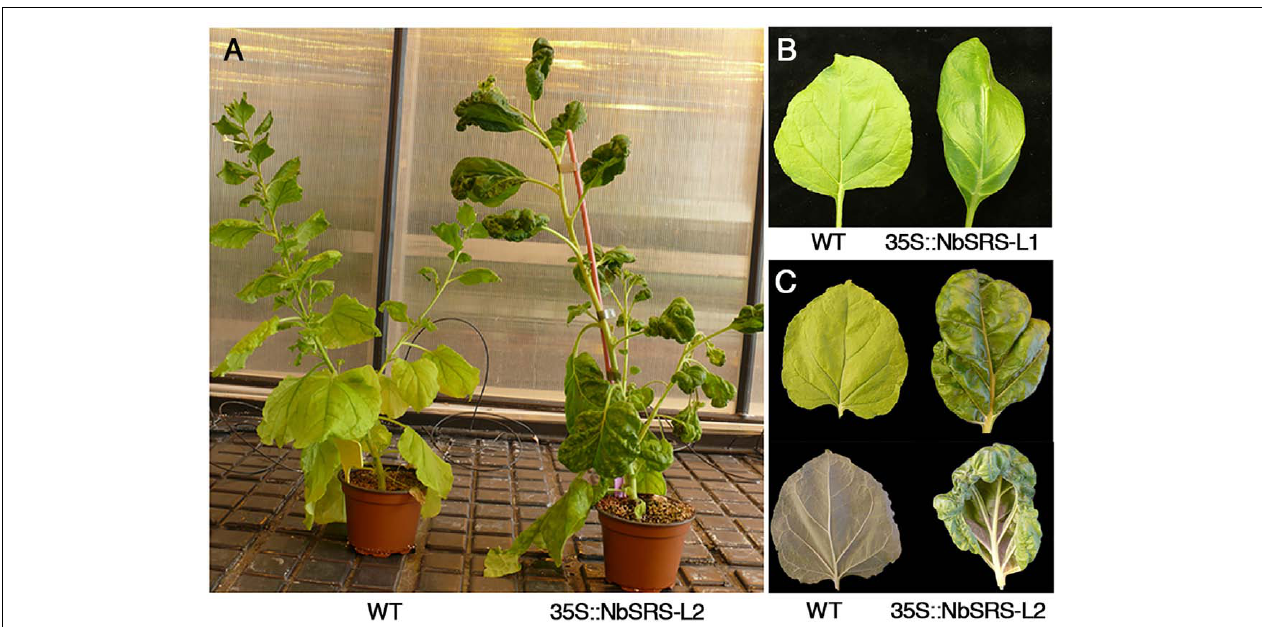
FIGURE 8 | Overexpression of NbSRS-L genes in N. benthamiana alters leaf development by constricting margin expansion. (A) Wild type (left) and 35S::NbSRS-L2 (right) plants of similar age. The 35S::NbSRS-L2 plant is darker, has slightly increased internode length and aberrant leaf shape. (B) Adaxial view of a fully expanded wild type (left) and a 35S::NbSRS-L1 (right) leaf. The leaf margin in the transgenic plant does not expand to the same extension as the blade, and the leaf is no longer flat. (C) Adaxial (top) and abaxial (bottom) views of a wild type (left) and a 35S::NbSRS-L2 (right) leaf. Note the dramatically constricted leaf margin of the transgenic leaf, which shows a much darker color and a highly irregular